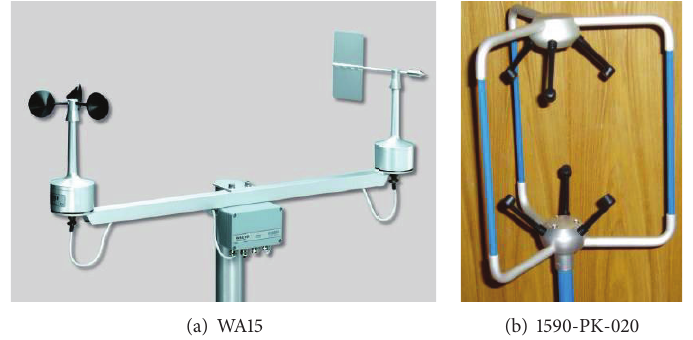
Figure 10: Anemometers installed on